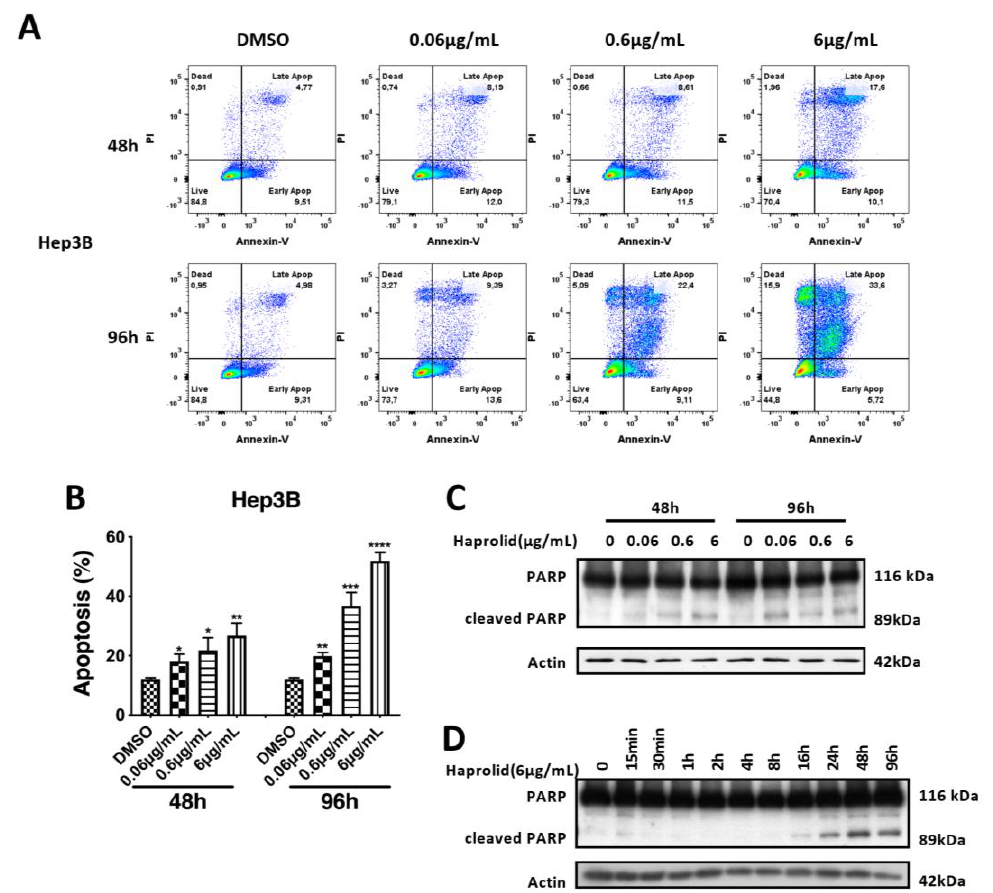
Figure 5. Haprolid treatment induces considerable apoptosis in Hep3B cells. ( A ) Hep3B cells were treated with DMSO or haprolid (0.06, 0.6 and 6 µg/mL) for 48 and 96 h, and the level of apoptosis was measured by staining with annexin V and PI using flow cytometry. Representative FACS measurements are presented. ( B ) The apoptotic positive cells were calculated and plotted in bar graph. ( C ) Expression of PARP and cleaved PARP (a marker for apoptosis) was measured by Western blotting. ( D ) Kinetic analysis of PARP cleavage was performed by Western blotting. Data represent means ± SEM of at least three independent experiments. * p < 0.05, ** p < 0.01, *** p < 0.001, **** p < 0.0001.